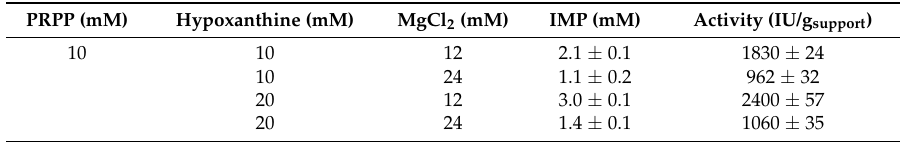
Table 2. Effect of substrate ratio in M Tt HGXPRT3 activity.